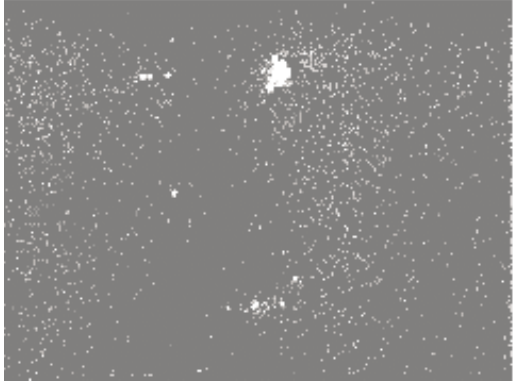
Fig. 9 – Image of the laser beam at approximately one second after the beginning of the pulse.